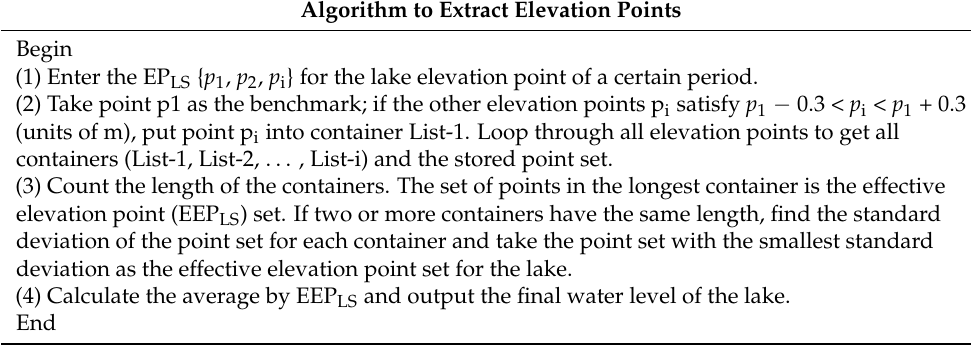
Table 3. Algorithm to extract elevation points. Algorithm to Extract Elevation